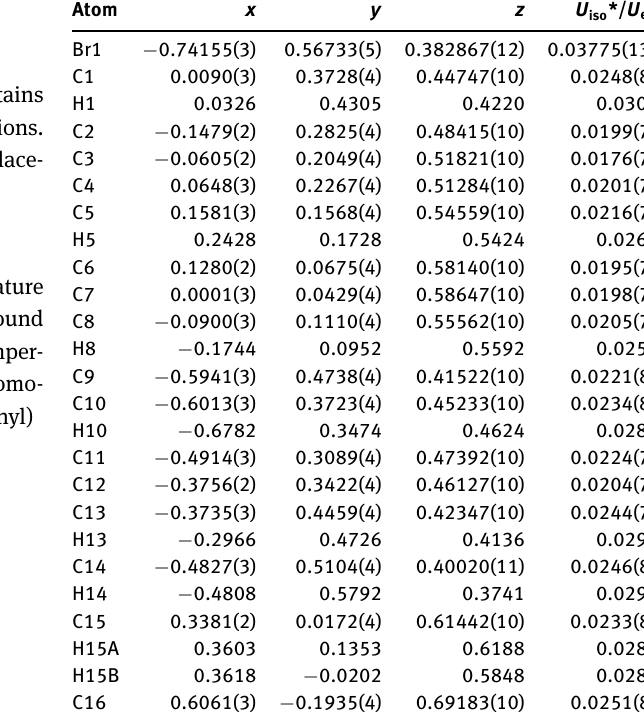
Table 2: Fractional atomic coordinates and isotropic or equivalent isotropic displacement parameters (Å 2